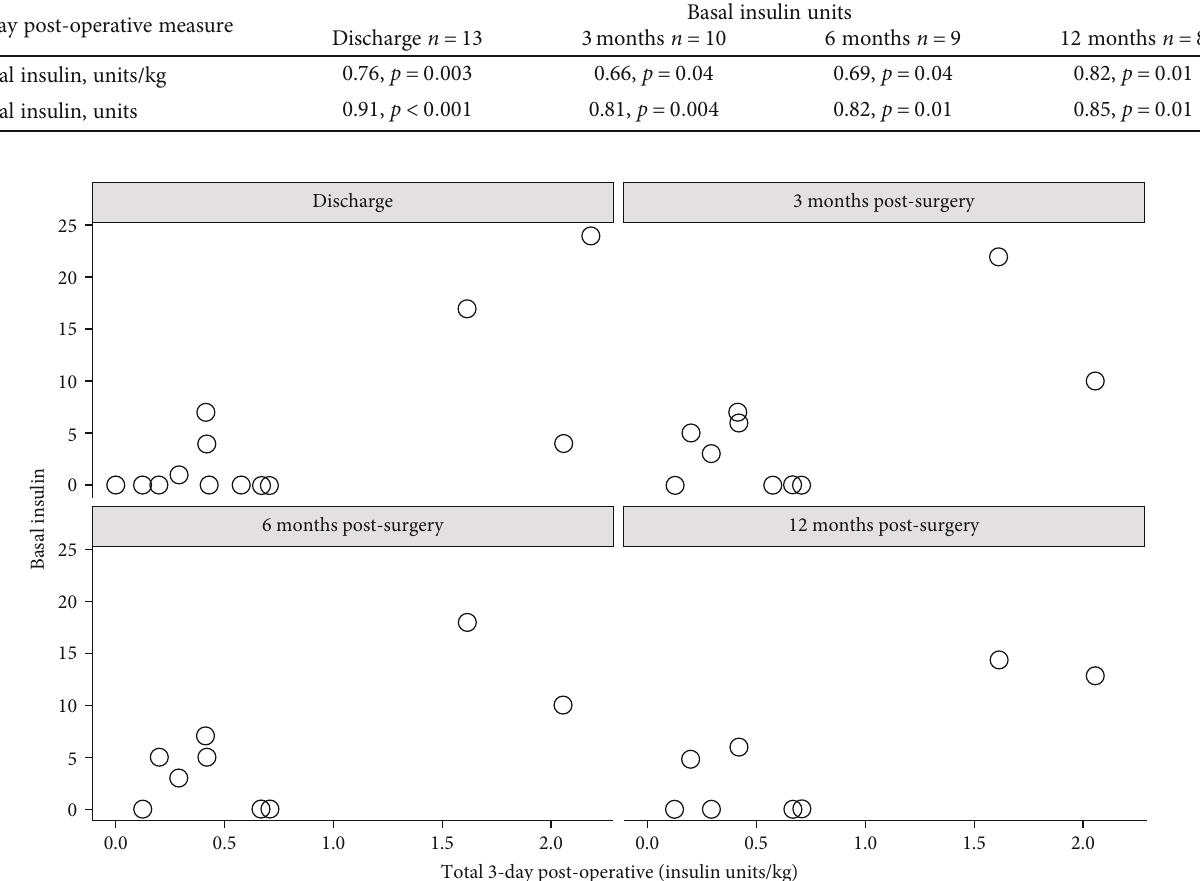
Figure 3: Postoperative basal insulin requirement per kilogram (insulin units/kg) in the immediate post-operative period of 72 hours showed a positive correlation with basal insulin requirement (units) at 3 months, 6 months, and 12 months postoperatively. These correlations were consistently strong and signi fi cant through 12 months